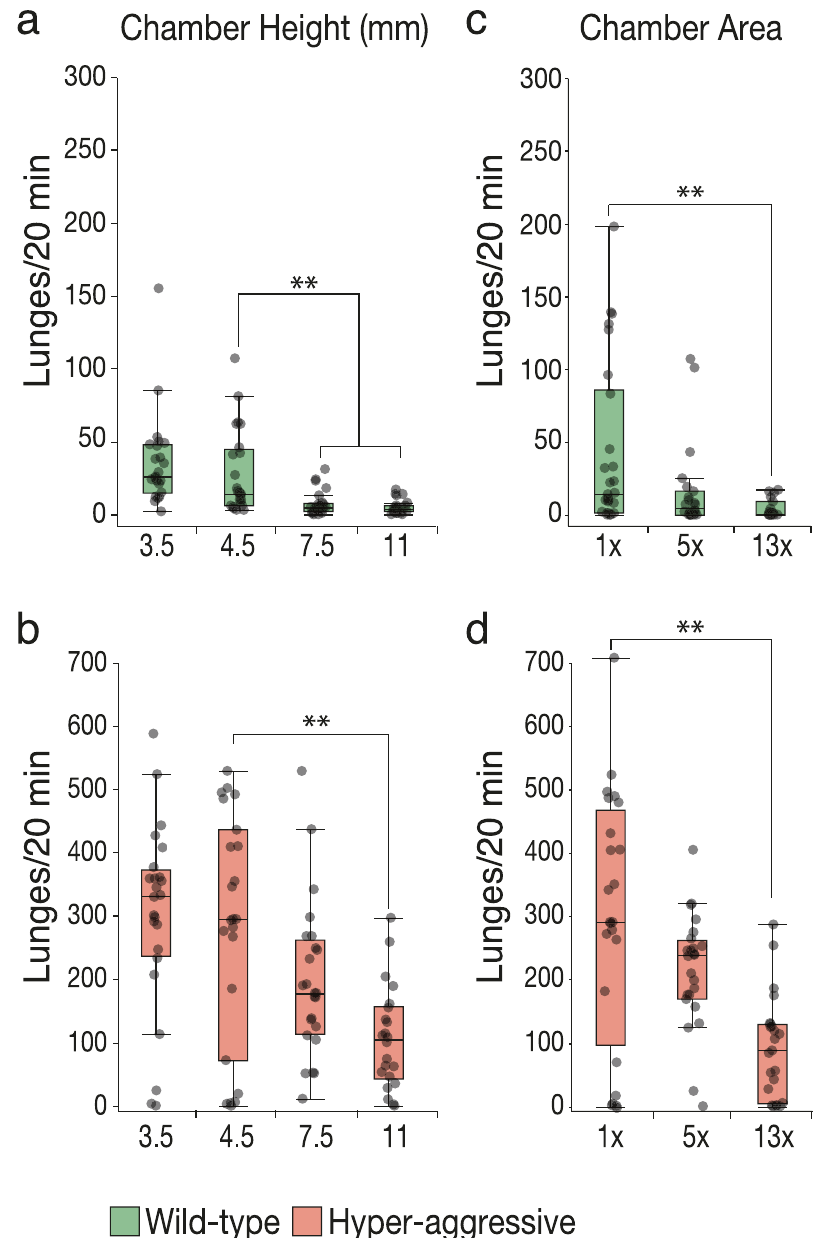
Fig. 2 Increased space decreases aggression. a Lunge numbers decrease with increasing height of the square arenas for low fi ghting control strain. There is no difference between 4.5 and 3.5 mm, which is approximately the height of a fl y raised on its hindlegs (nonparametric Steel method with 4.5 mm as control height, p = 0.34). As the height of the arena increases to 7.5 and 11 mm lunge numbers statistically signi fi cantly decrease (nonparametric Steel method compared to 4.5 mm as a control, 7.5 CS , p = 0.001; 11 CS , p < 0.001). b For hyper - aggressive fl ies, the decrease only became statistically signi fi cant at 11 mm (nonparametric Steel method compared to 4.5 mm height as control, 3.5 Aggr , p = 1; 7.5 Aggr , p = 0.11; 11 Aggr , p = 0.005, n = 22 – 24 per group). c , d Increasing the surface area of the arenas ~5 to 13-fold by doubling or tripling the width of the arena also decreased aggression. In both low and high aggression strains, the difference becomes statistically signi fi cant when the arena width is tripled (nonparametric Steel method with 1× surface area as the control, 1× CS vs. 5× CS , p = 0.07; vs. 13× CS p = 0.002; 1× Aggr vs. 5× Aggr , p = 0.07; vs. 13× Aggr p = 0.001, n = 17 – 24 per group). Boxplots show the median, fi rst and third quartiles as boxes, with whiskers representing the 5 and 95% tripling the width of the arena, which increases surface area ~5 11 mm as in the Arena Assay however decreased aggression. The times (9 cm 2 ) and ~13 times (22 cm 2 ), respectively (Supplemen- decrease with one additional fl y length was signi fi cant in wild- tary Data 3). A fi vefold increase in arena surface decreased type CS low aggression fl ies, but not in hyper-aggressive fl ies, aggression although the decrease did not reach statistical while the 11-mm height signi fi cantly decreased aggression in both signi fi cance. A 13-fold increase in surface area led to a statistically low and high aggression strains (Fig. 2a, b, nonparametric signi fi cant drop in aggression in both strains (Fig. 2c, d, Steel method with control, 4.5 CS vs. 7.5 CS , p = 0.001; vs. 11 CS , p < nonparametric Steel method with 1× standard surface area as 0.0001; 4.5 Aggr vs. 7.5 Aggr , p = 0.11; vs. 11 Aggr p = 0.005, n = 22 – 24 per group). We next increased surface area by doubling or the control, 1× CS vs. 5× CS , p = 0.07; vs. 13× CS p = 0.002; 1× Aggr